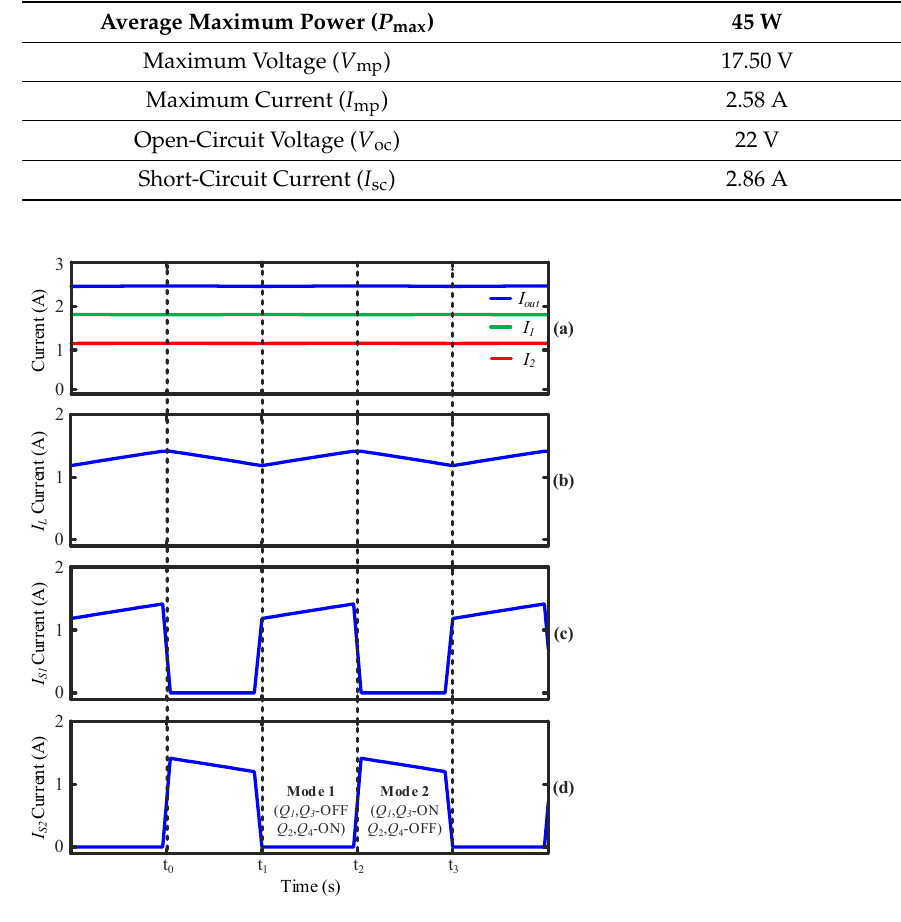
Figure 8. Simulated results under scenario 2 ( SM1 is shaded) for the proposed SCL -based DPP topology: ( a ) Output current and submodules current, ( b ) mismatch current ( I L ) passing through the inductor L ( c ) current passing through Q 1 and Q 3 , ( d ) current passing through Q 2 and Q 4